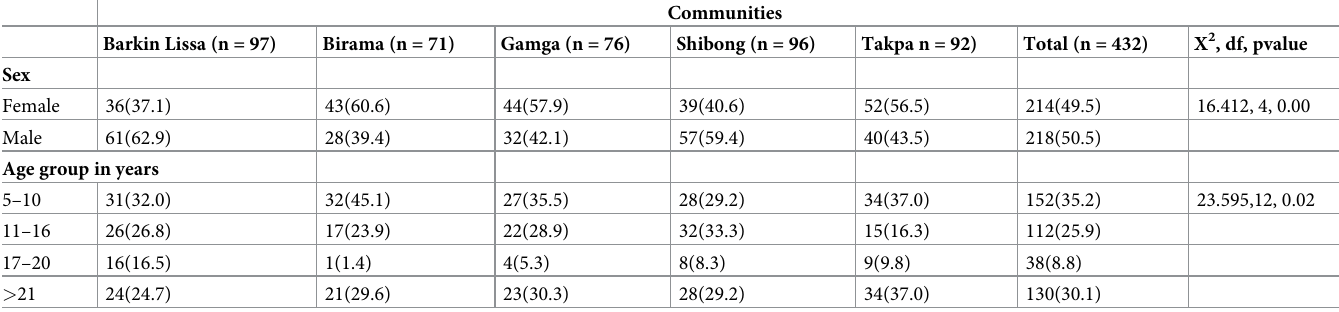
Table 1. Demographic characteristics of the study population.